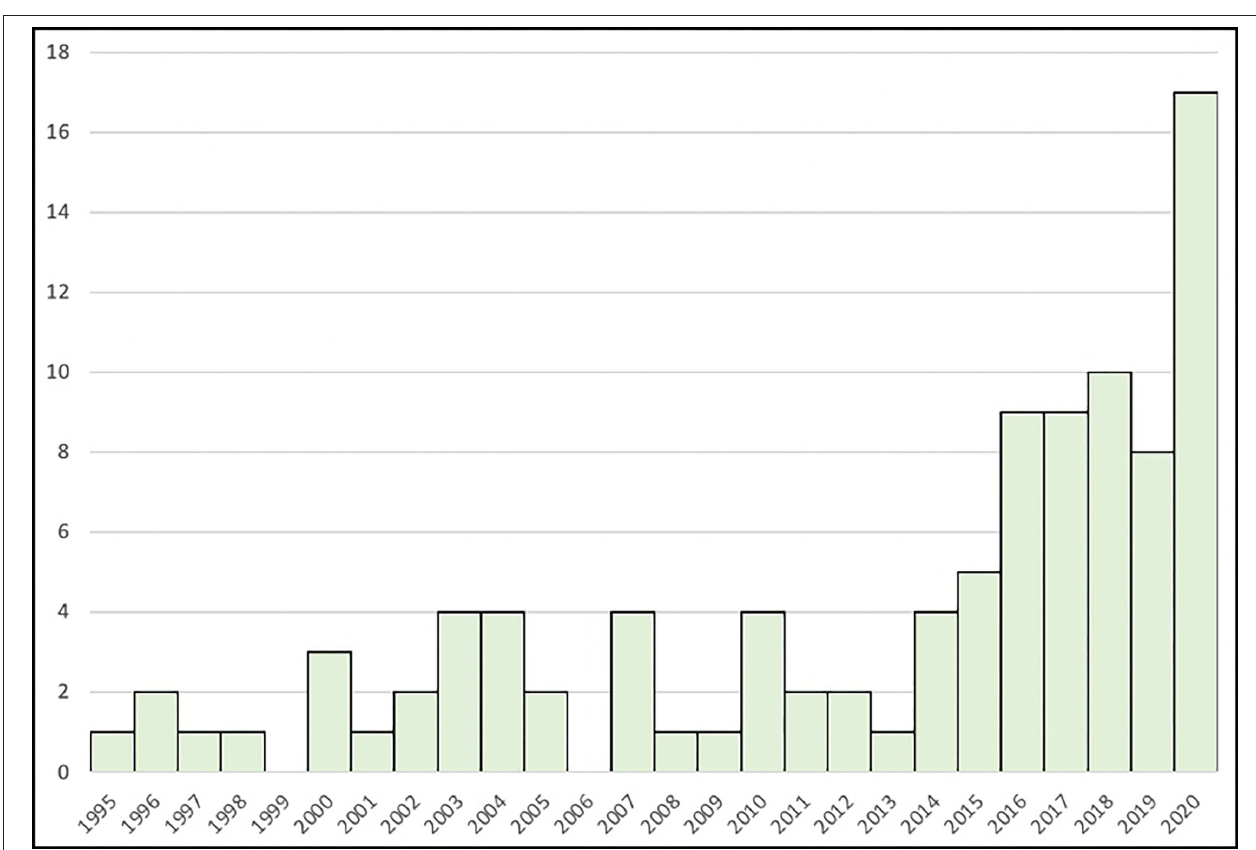
FIGURE 1 | Number of studies using rPMS between 1995 and 2020 and meeting the selection